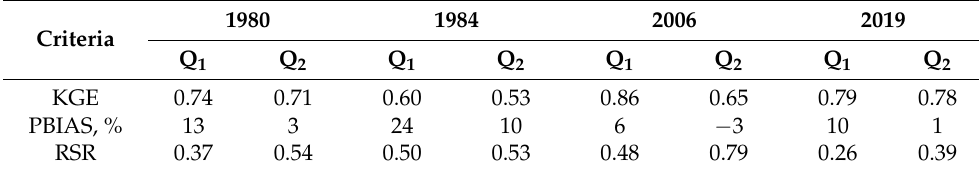
Table 5. Evaluation of the correspondence between observed and simulated discharges at Tu- lun gauge for the floods in 1980, 1984, 2006 and 2019 using the KGE, PBIAS and RSR criteria (Q 1 –discharges for the entire period of flood, Q 2 –discharges above the critical water level).